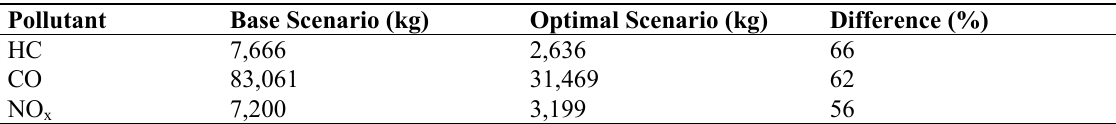
Table 5. Aggregate emissions of HC, CO and NO et al. 1997)